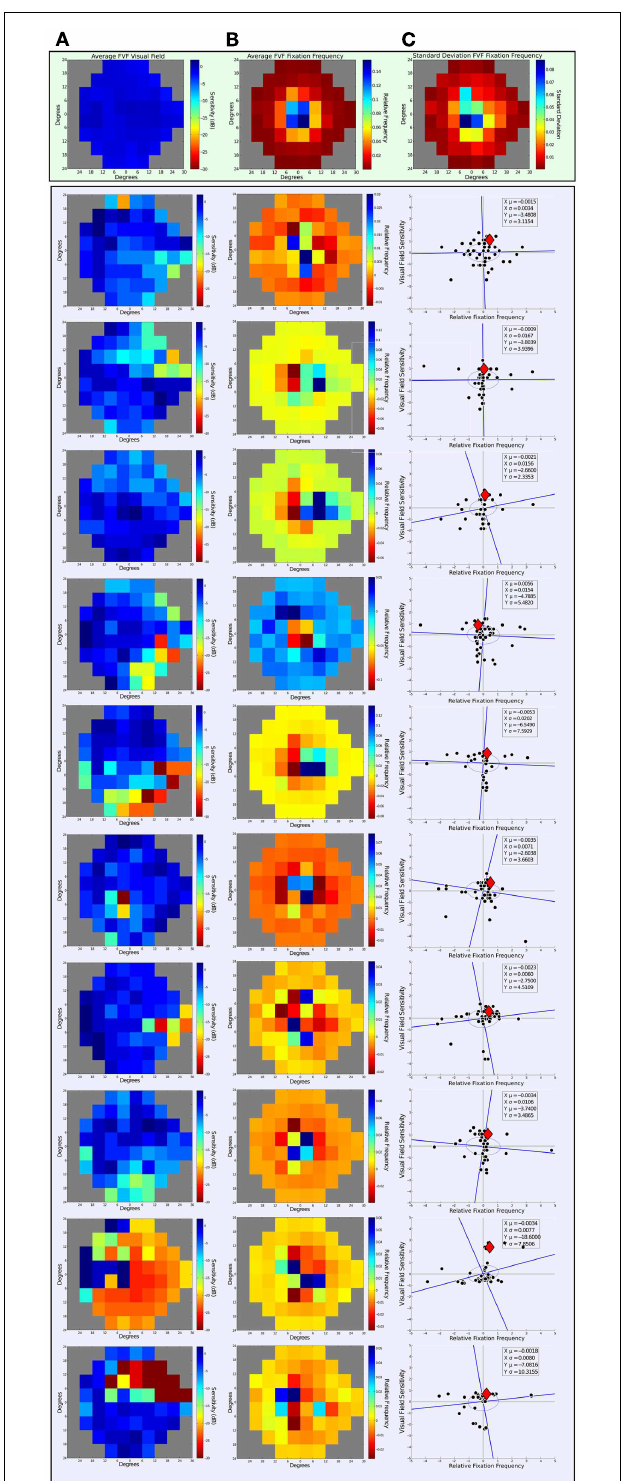
FIGURE 4 |Visual field sensitivity and fixation landing points. The top rectangle contains data from the FVF group and the larger bottom rectangle contains data from each of the 10 PVFL patients. Column A shows the heat